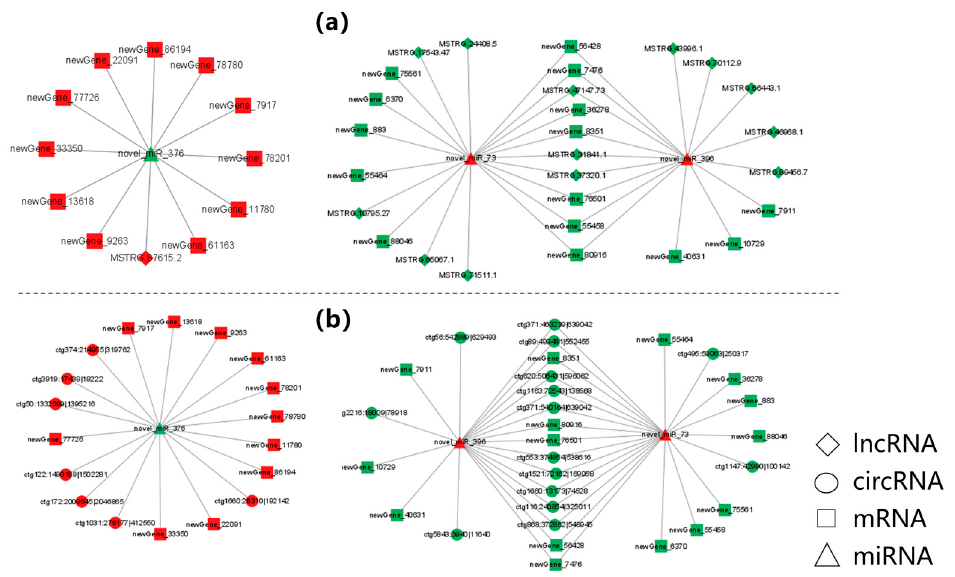
Figure 5. Interaction diagram of ceRNA network related to osmoregulation. ( a ) Parts of lncRNA- miRNA-mRNA regulatory network. ( b ) Parts of circRNA-miRNA-mRNA regulatory network. Red and green nodes represent up-regulated and down-regulated transcripts, respectively.